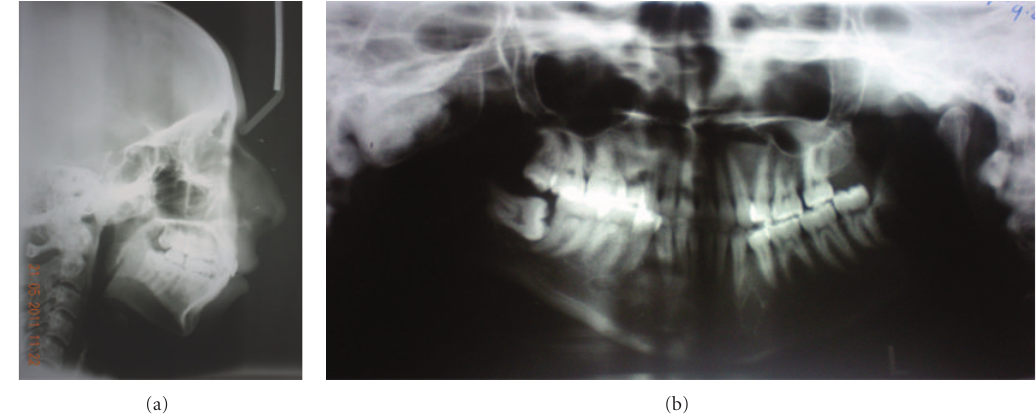
Figure 5: (a)-(b) radiographs after completion of orthodontic treatment and before genioplasty.